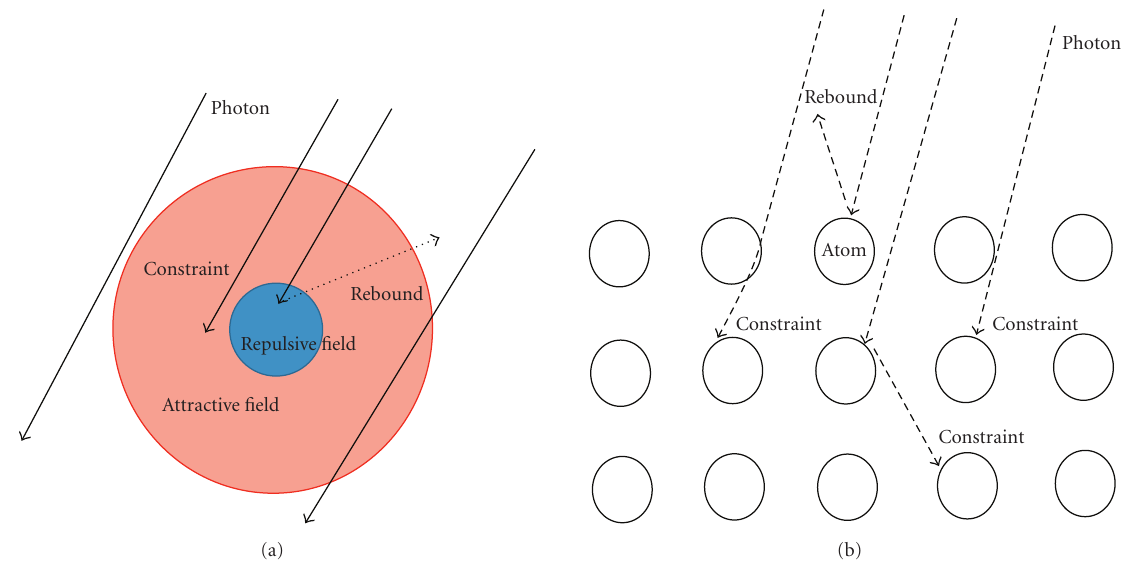
Figure 1: Illustrations of attractive and repulsive interactions of atoms and photons. (a) The photons moves toward repulsive force field are probably rebound out, and the other photons move through attractive field is constrained or decelerated. (b) The rebounded behavior is as same as reflection. The constraint behavior is as same as